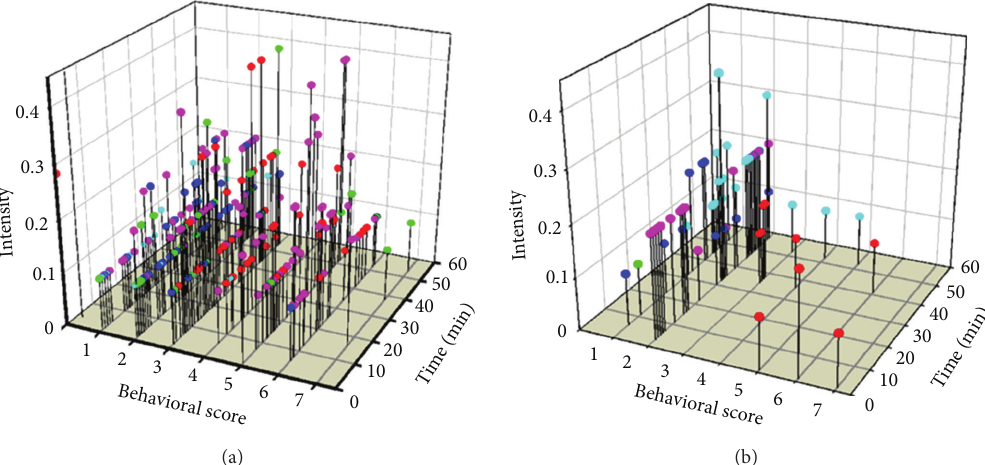
Figure 4: Comprehensive representation of social interactions for cave crayfish in low white light (25 lux). (a) In water. (b) Out of water. A single vertical line indicates a given behavior at a specific point in time as well as the intensity of the behavior. The different colored points represent individual pairs in the trials (𝑁 = 5)